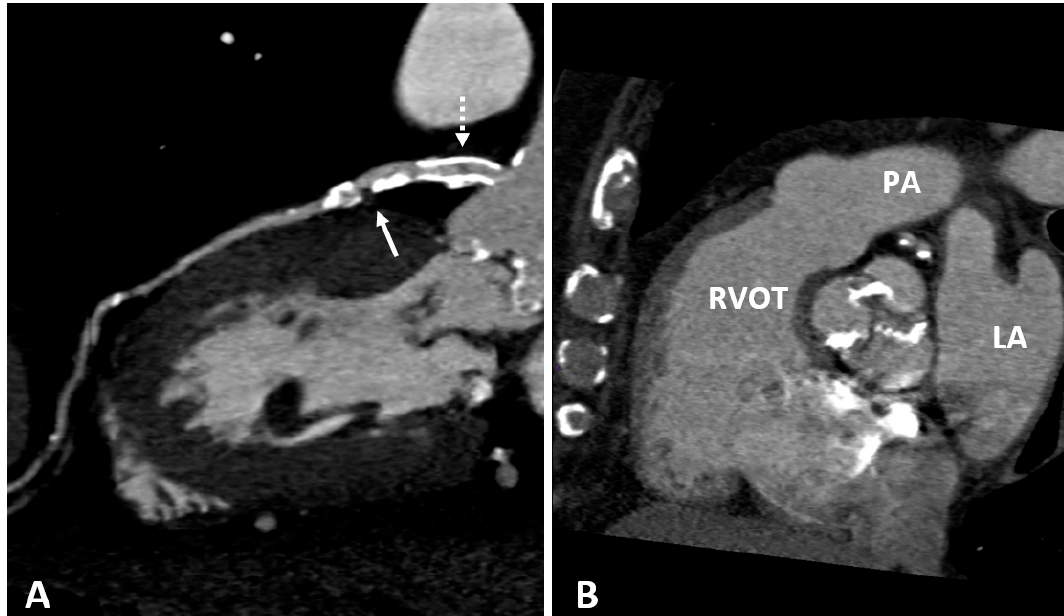
Figure 3. ( A ) CTCA showing the left main (LM) and left anterior descending (LAD) coronary arteries of a patient who underwent coronary angioplasty (PTCA) and stent positioning in the LM. A non ‐ calcified low density soft plaque (white arrow) is shown between calcific plaques; the hypodense spot (dashed white arrow) within the stent may indicate initial intrastent restenosis. Calcification of the aortic valve leaflets. ( B ) CTCA of the same patient reformatted in the plane of the aortic valve shows calcification of the aortic leaflets. RVOT: right ventricle outflow tract; LA: left atrium; PA: pulmonary artery.